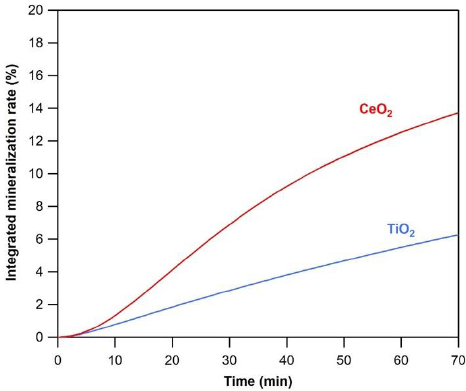
Figure 8. Temporal evolutions of the mineralization percentages of organics adsorbed on TiO 2 and CeO 2 along the individual exposure to ozone of the metal oxides preliminarily exposed to acetone; reported data are derived from Figure 7 (flow rate = 750 mL/min, [O 3 ] 0 = 22 ppm for CeO 2 experiments, [O 3 ] 0 = 24 ppm for TiO 2 ; 100 mg CeO 2 , 200 mg TiO 2 ).